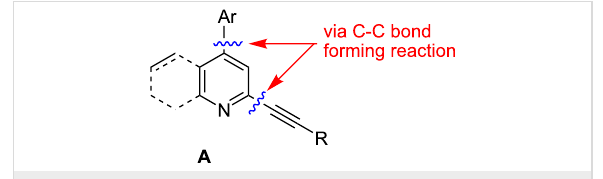
Figure 1: 2-Alkynyl-4-aryl pyridine and its benzo derivative.